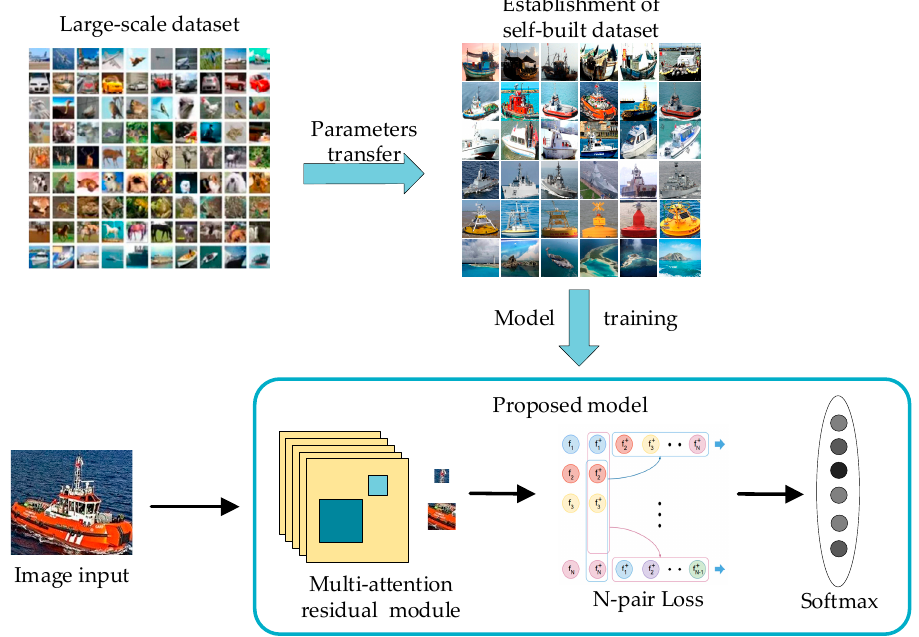
Figure 1. Illustration of the proposed algorithm. At the top, a limited self-built dataset is established and parameters of large-scale datasets are transferred into the former. At the bottom, an image is input into the multi-attention residual model, and then N-pair loss based on metric learning is used for classification.